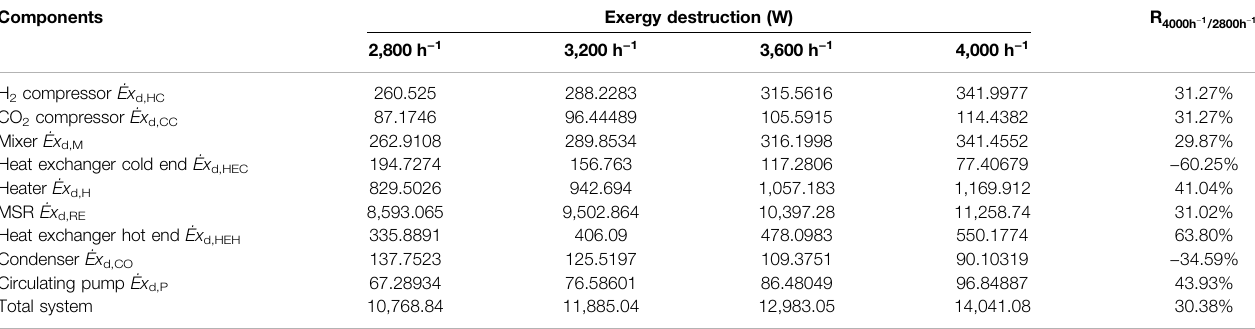
TABLE 5 | Exergy destruction in the CDHM system under different space velocities. Components